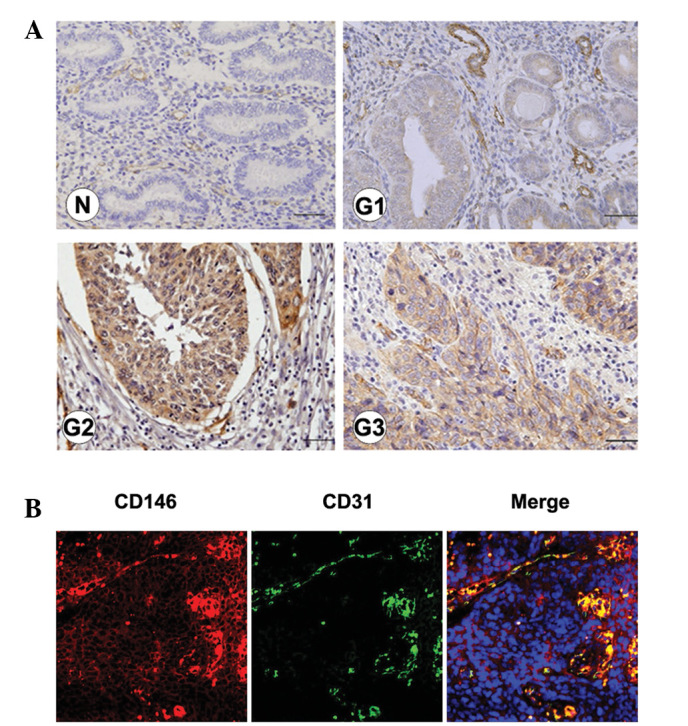
Expression of CD146 in the clinical samples of normal and cancerous endometrial tissue. (A) Representative immunohistochemical staining of CD146 in vascular endothelial cells and tumor cells in the collected tissues, including: (N) Normal hyperplasia endometrium; (G1) a highly differentiated grade of endometrial cancer; (G2) a moderately differentiated grade of endometrial cancer; and (G3) a poorly differentiated grade of endometrial cancer. (B) Expression of CD146 in vascular endothelial cells was confirmed using anti-CD31 as an endothelial marker in a fluorescent immunohistochemistry assay. CD146, red; CD31, green; Merge, overlapped images of former pictures and nuclei were stained with DAPI (blue). Scale bars, 100 μm. CD146, cluster of differentiation 146.